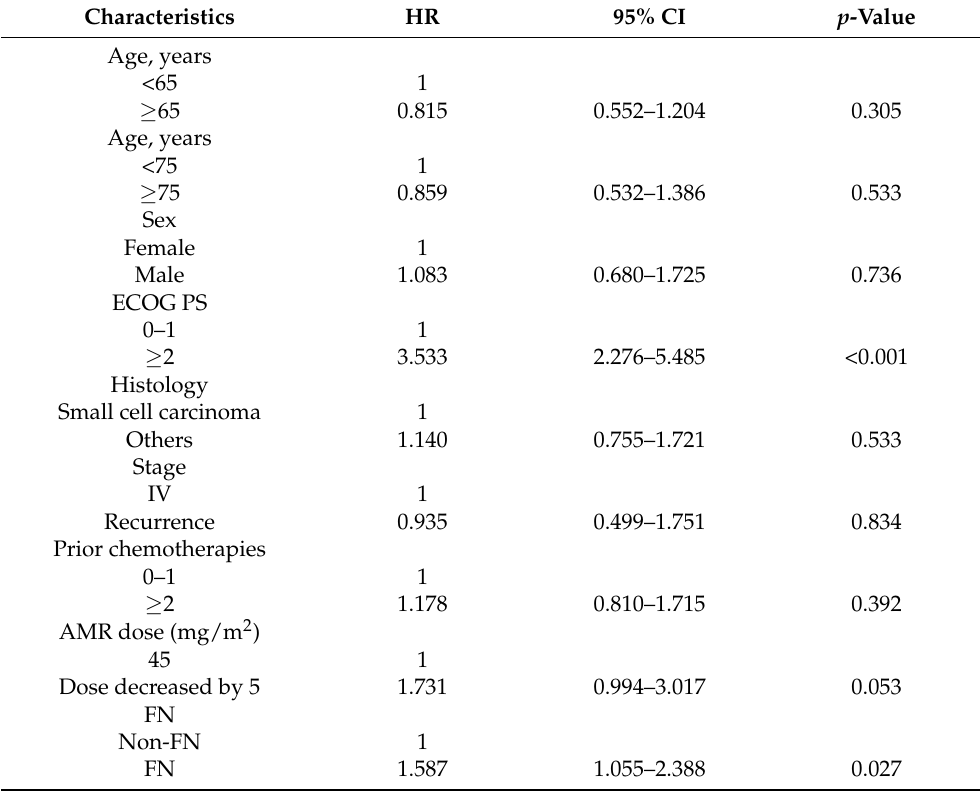
Table 3. Potential risk factors for OS by the univariate Cox proportional hazards analysis ( N = 156).